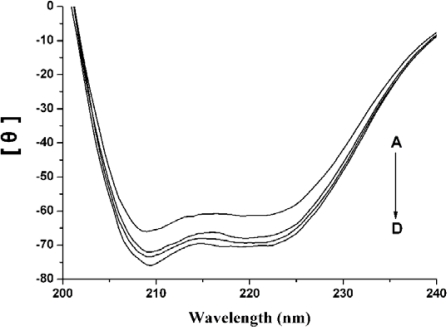
The circular dichroism (CD) spectra of the HSA-nC60 system. Concentration of HSA was 7.3 μM; Concentration of nC60 (from A to D) was 0, 3.38, 5.63, 11.8 μM, respectively.